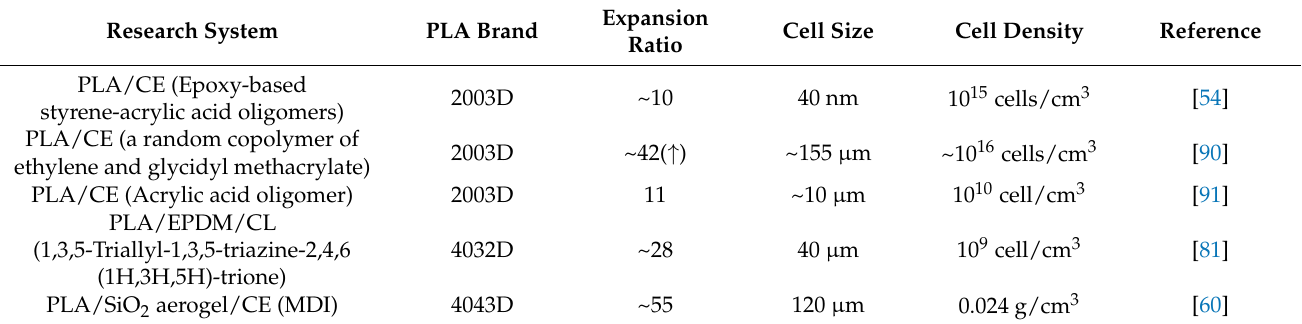
Table 2. Research on chemical modification of polylactic acid-based foams from 2020 to